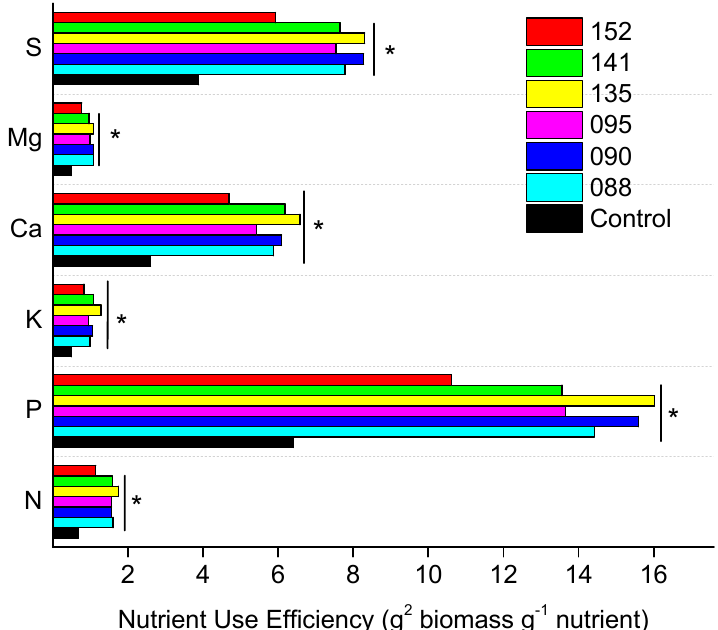
Figure 4. Nitrogen, phosphorus, potassium, calcium, magnesium, and sulphur use efficiency of sugarcane seedlings inoculated or not (Control) with six bacterial strains (IAC-BECa-088, IAC-BECa-090, IAC-BECa-095, IAC-BECa-135, IAC-BECa-141, IAC-BECa-152) 45 days after transplanting. * Indicates significant differences among bacterial treatments by the Scott-Knott test ( p < 0.05).